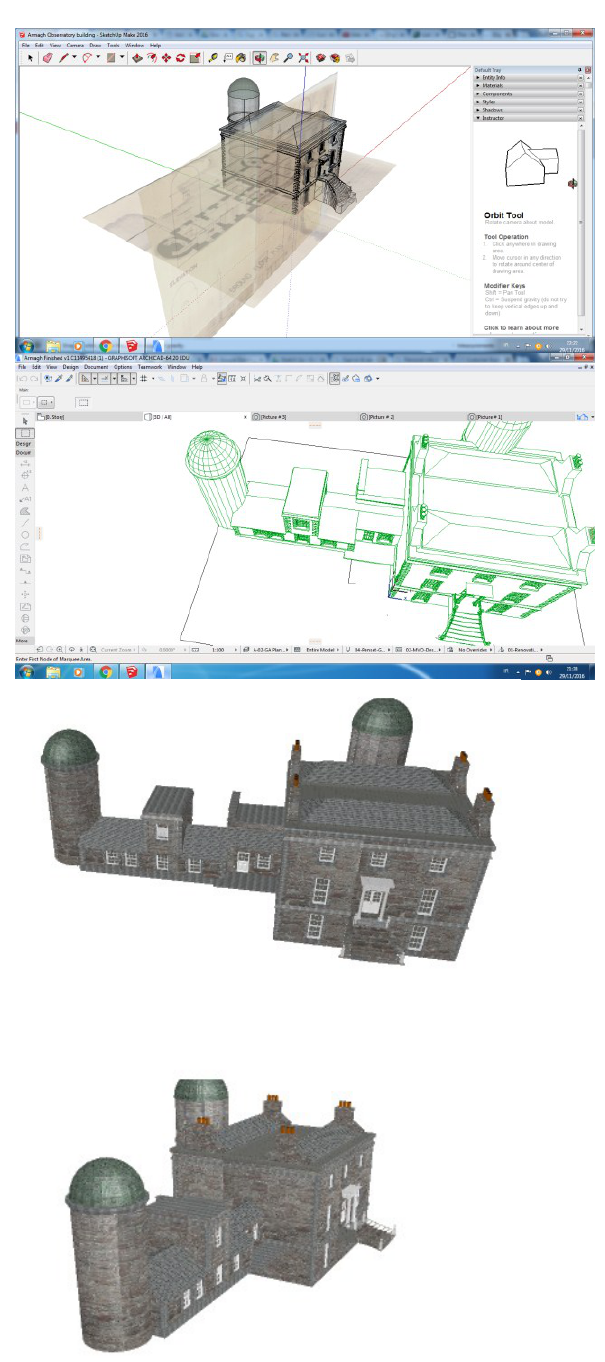
Figure 4: Historic Building Information Model of Armagh